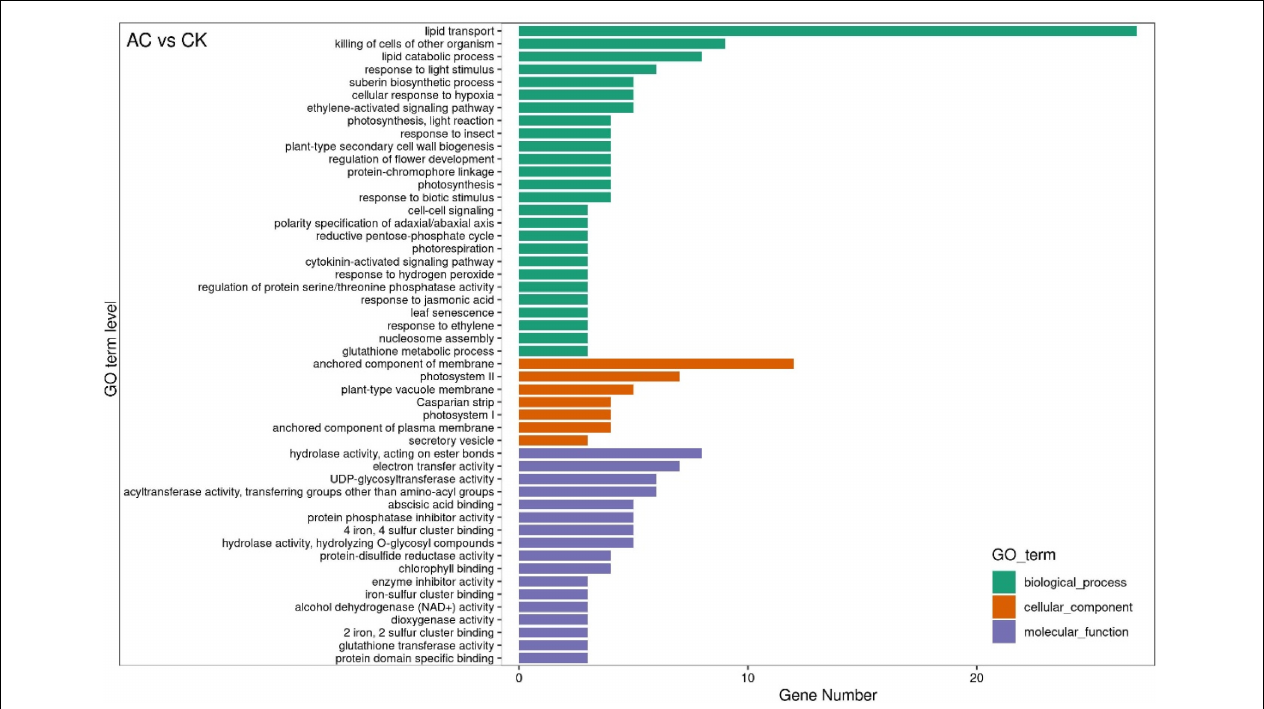
FIGURE 5 | The GO functional classification of DEGs between the activated carbon (AC) and control check (CK). The graph is drawn using the first 20 terms with the smallest P -value. The ordinate is GO term, and the abscissa is the number of genes with different numbers of GO term.